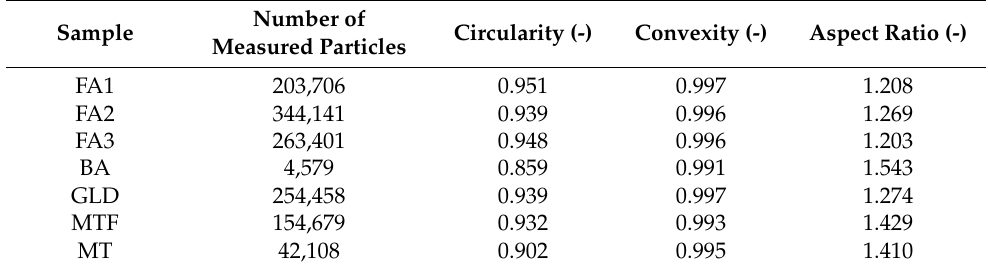
Table 4. Circularity, convexity and aspect ratio of each